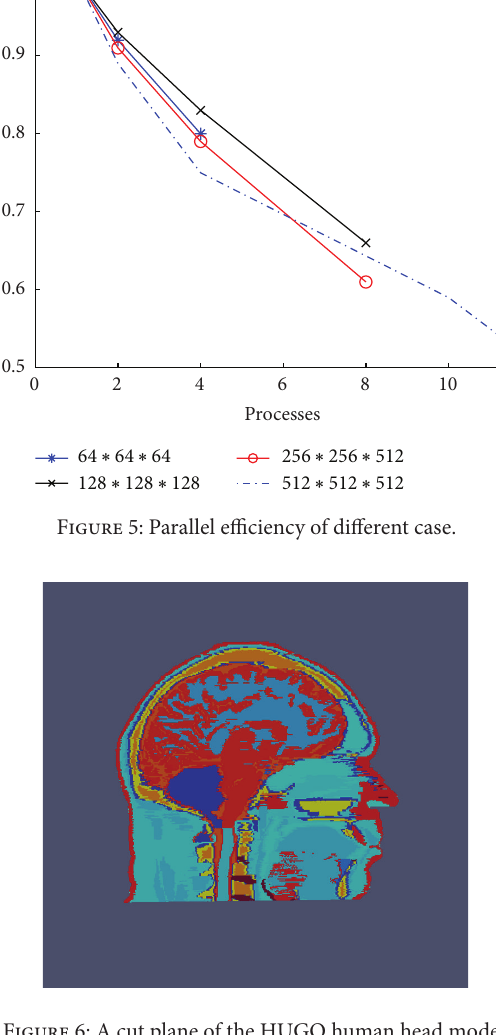
Figure 6: A cut plane of the HUGO human head model.